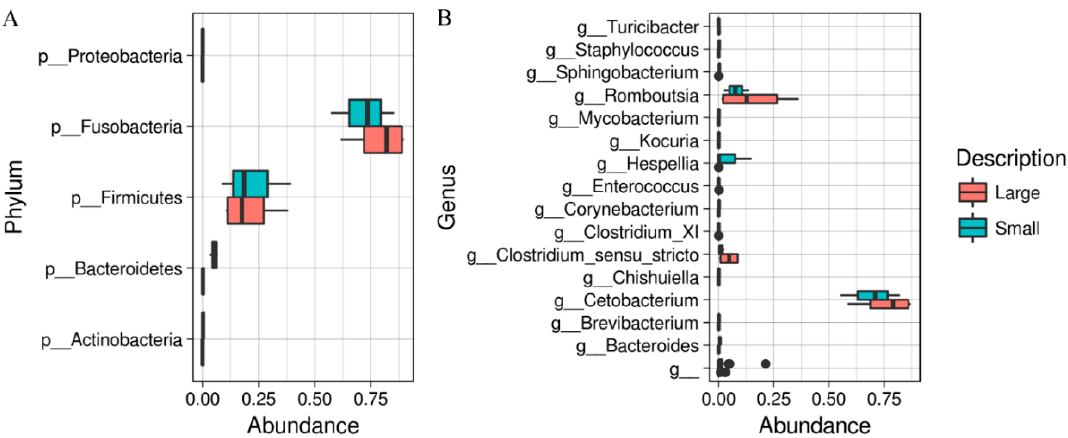
considering p < 0.05.